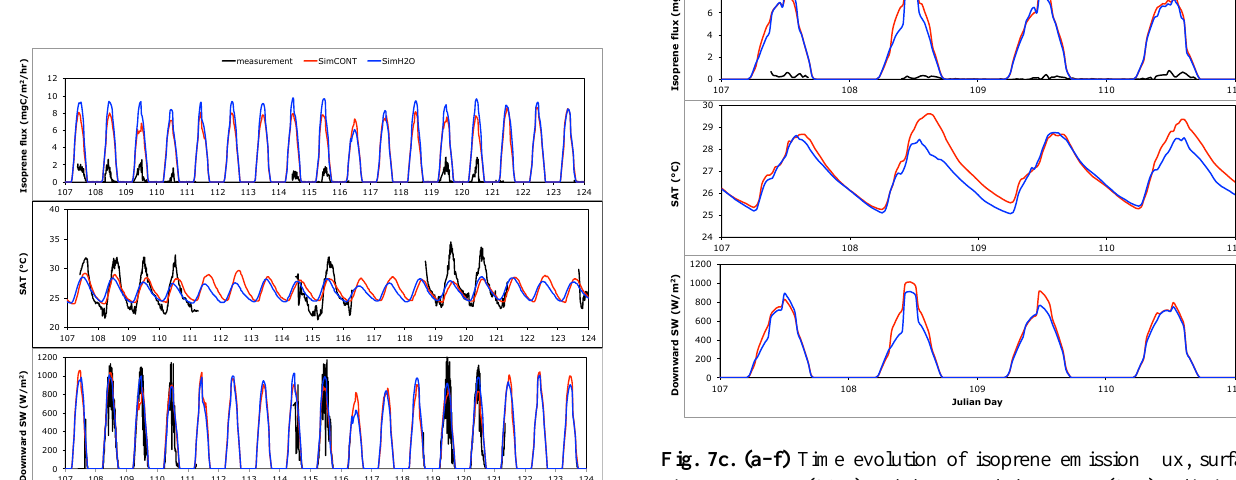
Fig. 6. Scatter plot of the simulated isoprene emissions against mea- Figure 6. Scatter plot of the simulated isoprene emissions against measurements from the global above-canopy flux database sorted by ecosystem type (Table 5). ‘Plantation’ measurements are surements from the global above-canopy flux database sorted by lumped into ‘crop’ here. Units are mgC/m 2 /hr. Values and temporal averaging periods are ecosystem type (Table 5). “Plantation” measurements are lumped detailed in Table 5. into “crop” here. Units are mgCm − 2 h − 1 . Values and temporal av- eraging periods are detailed in Table 5.